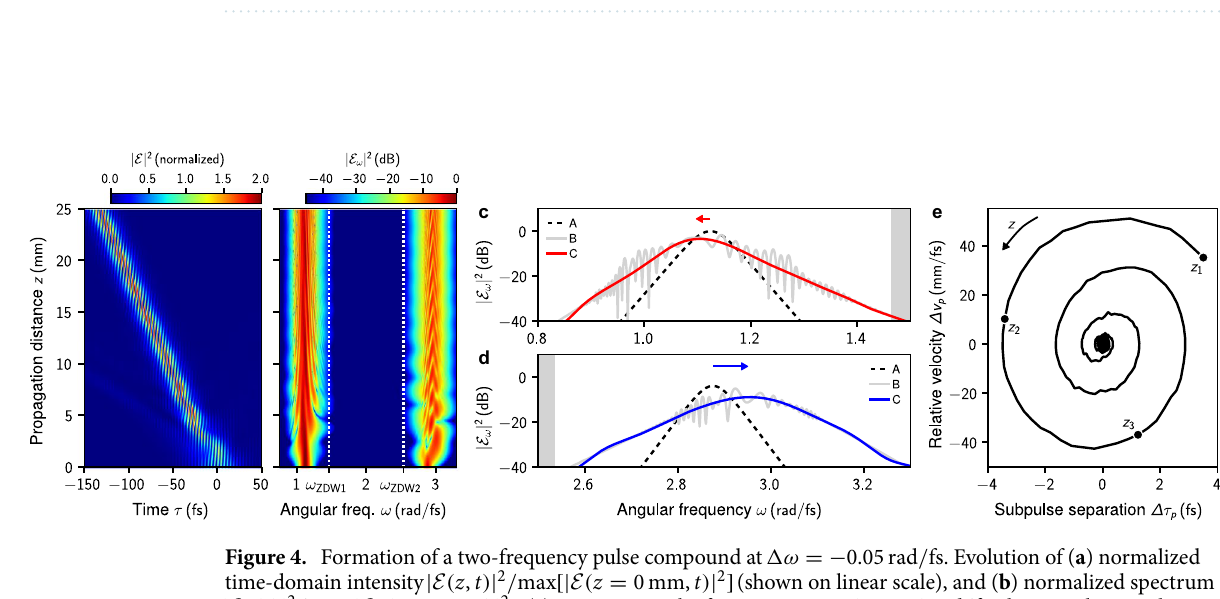
Figure 3. Characterization of the crossover from mutual trapping to escape. ( a – c ) Results for γ(ω) given by Eq. (3). ( a ) Point particle motion in an attractive potential. The particle can escape the well if its kinetic energy T class kin exceeds the potential depth U 0 (see text for details). Parameter range in which the particle cannot escape the well is shaded gray. Secondary ordinate shows the trapping coefficient C tr computed in a simplified model for a soliton interacting with a localized attractive potential (see text for details). ( b ) Comparison of observed asymptotic velocities v 1 and v 2 of the dominant localized pulses in the distinct domains of anomalous dispersion and corresponding propagation constant based group-velocities v g . Light-green solid and dashed lines indicate the group velocities v g (ω ′ 1 ) and v g (ω ′ 2 ) , obtained for the shifted pulse center frequencies ω ′ 1 and ω ′ 2 , respectively 25mm , quantifying the degree of mutual (see text for details). ( c ) Logarithm of the overlap parameter q at z = 0.143 rad / fs indicates region in which group-velocity trapping (see text for details). Shaded area beyond �ω ≈ γ 0 . matching cannot be achieved, cf. Fig. 1a. ( d – f ) Same as ( a – c ) considering γ(ω) =